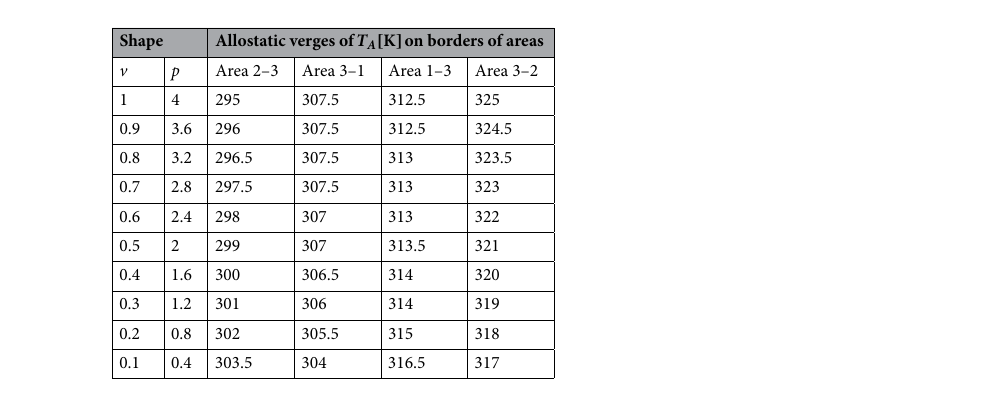
Table 5. Estimated allostatic verges of the ambient air temperature T A [ K ] on borders of areas 1, 2 and 3 depending on the shape of the saturation curve (described by some values of parameters p , v ) for the area 2 min − 1 below the saturation curve E S = 4K .